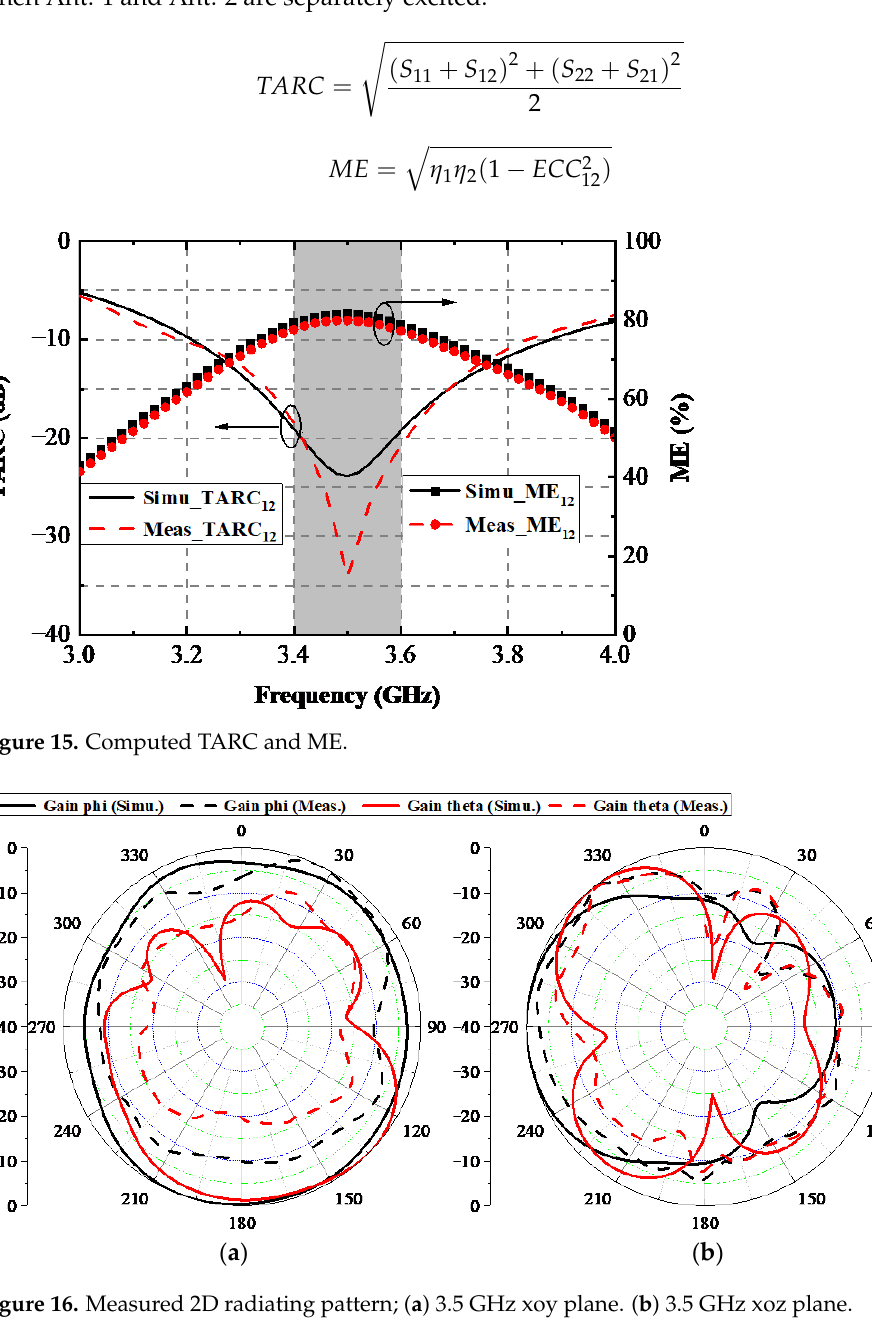
Table 1. Performance contrast between the proposed AP system with other state-of-arts.